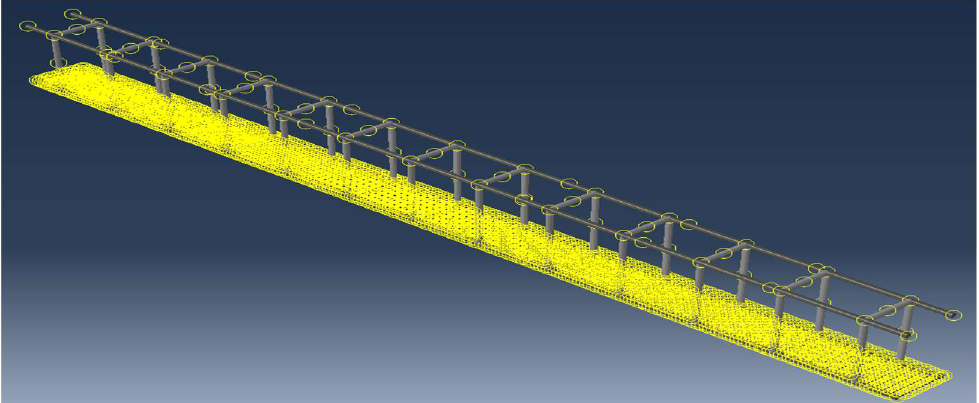
Figure 18. Interaction of Reinforcement.